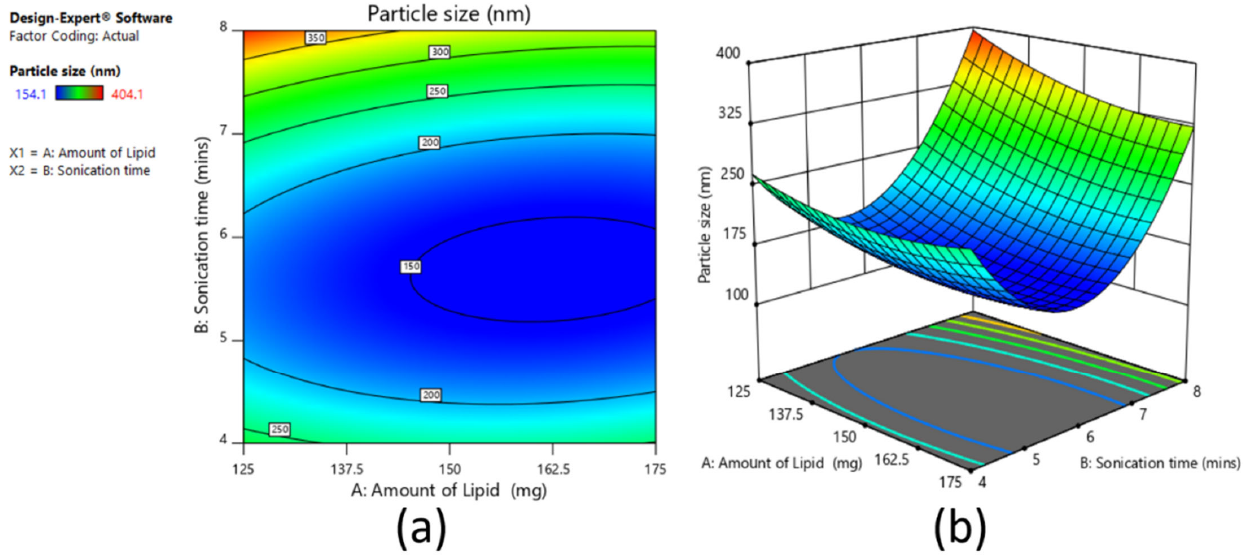
Figure 5. Contour plot ( a ) and 3D surface plot ( b ) representing the effect on particle size for full factorial design